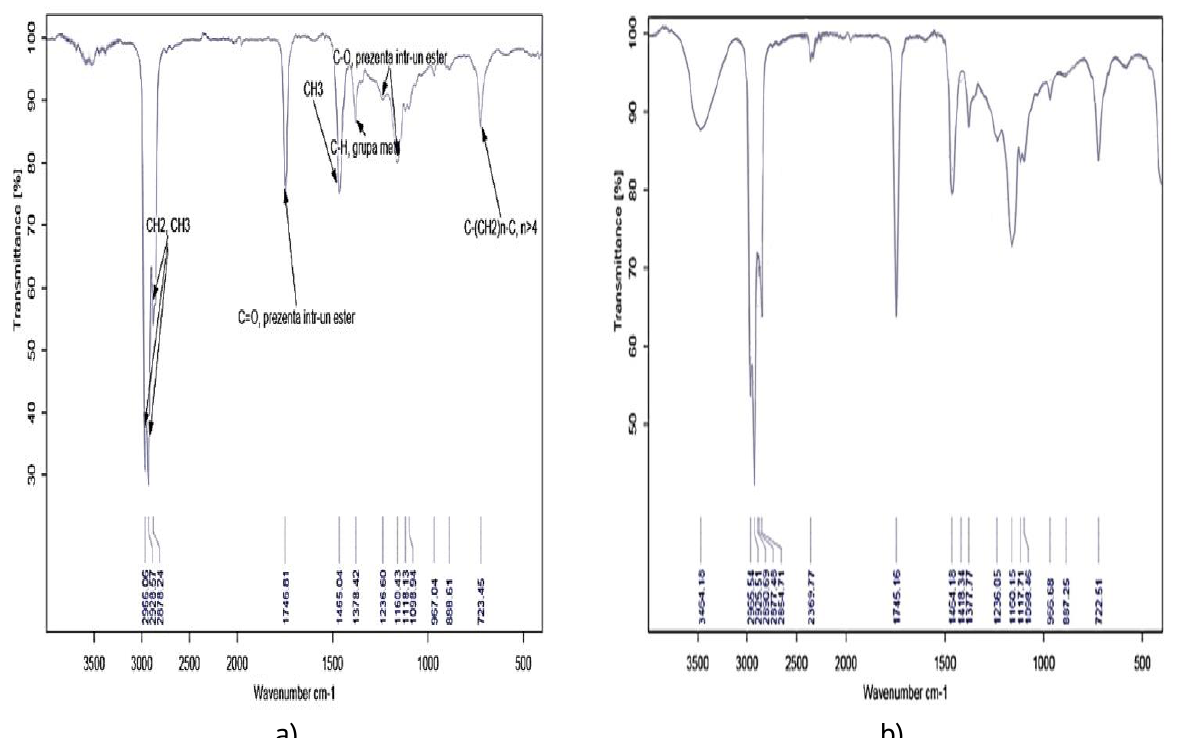
Figure 4. IR spectra of fresh (a) and thermo-oxidited (b) oil